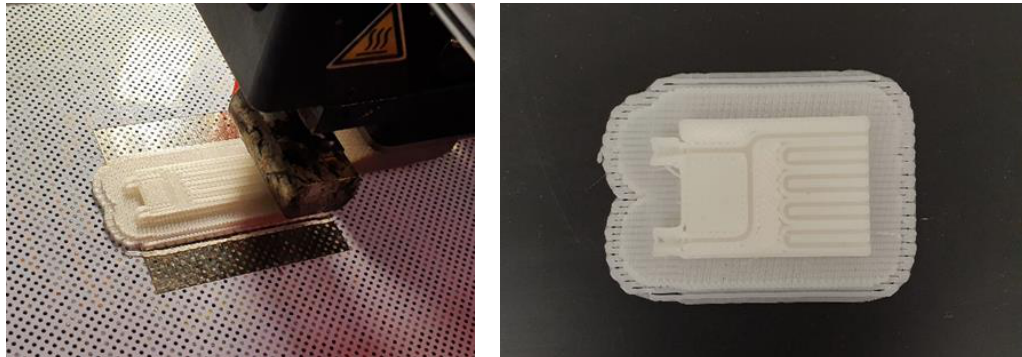
Figure 14. Production process of a microreactor produced by 3D printing and a part of a microreactor with visible microchannels.